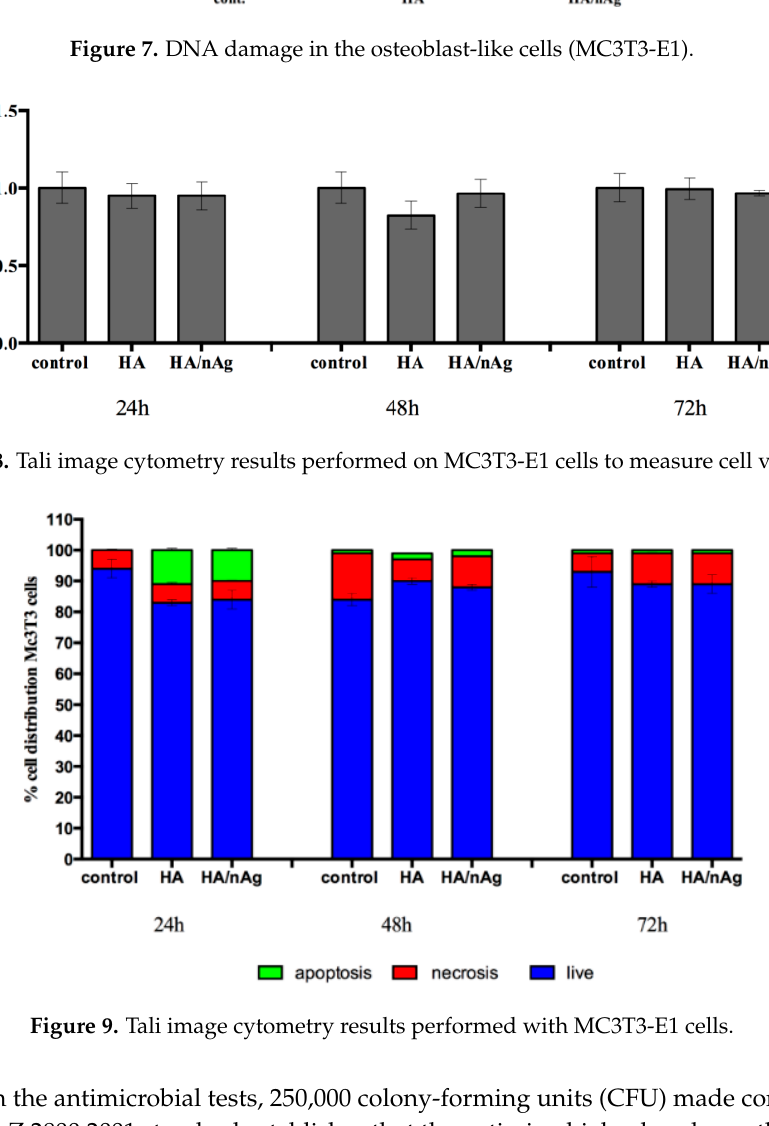
Molecules 2017 , 22 , 1291